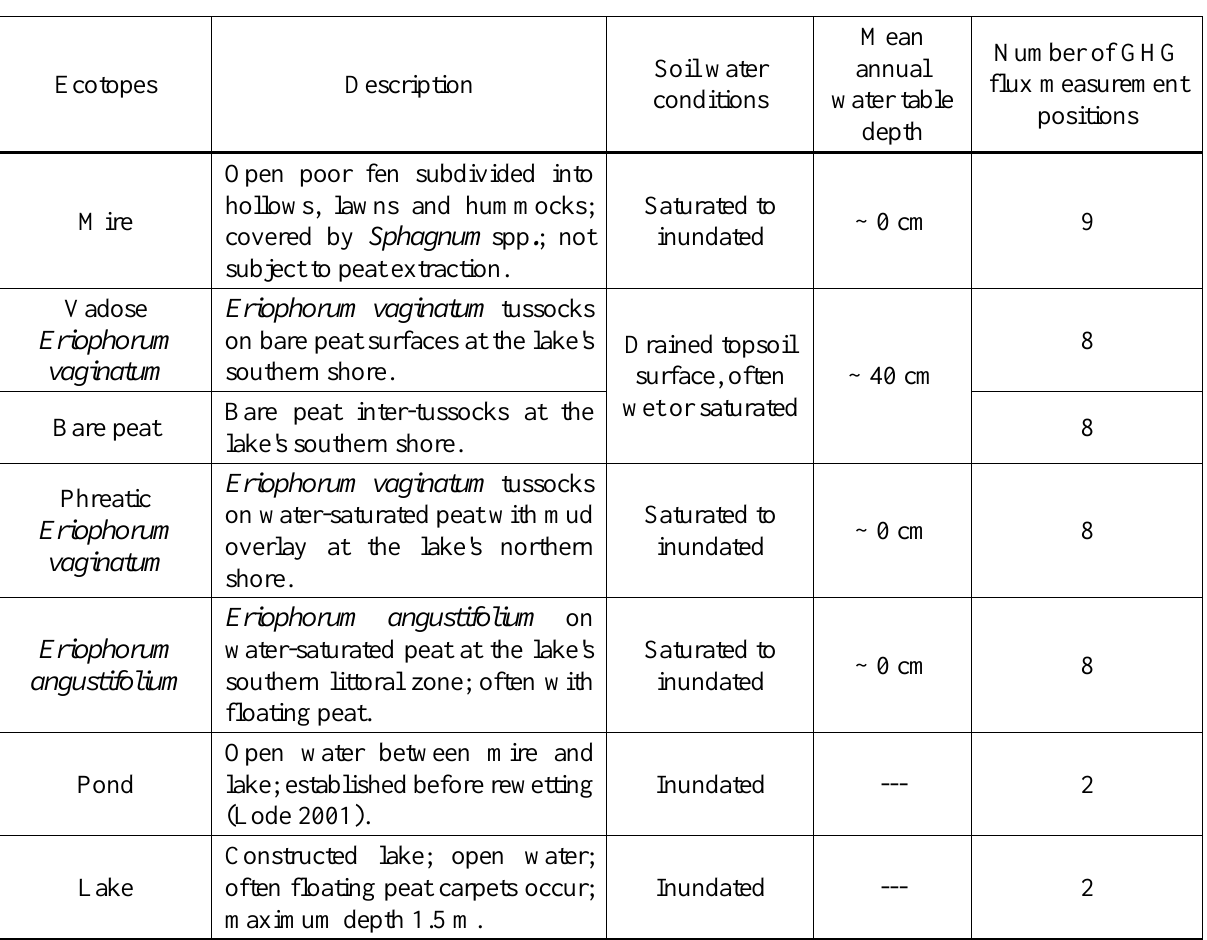
Table 1. Descriptions of the seven ecotopes investigated.